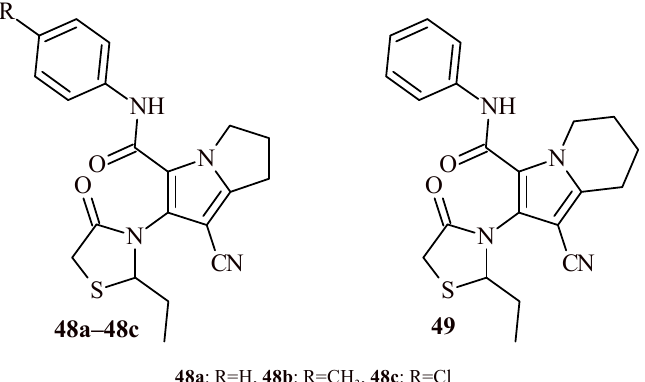
Figure 21. Pyrrolizine-thiazolidin-4-one derivatives with anticancer activity. Lesyk et al. synthesized series of ciminalum-rhodanine hybrids and conducted screening of obtained compounds for their antitumor activity according to the NCI DTP (USA) standard protocol at the concentration in the range 10 − 4 –10 − 8 M against 60 tumor cell lines [55]. The results of screening of ciminalum-rhodanine hybrids confirmed their significant anticancer properties. Compounds 50 and 52 (Figure 22) showed growth inhibition of all tested tumor cell lines at submicromolar and micromolar concentrations. Worth noticing that the most active Compound 52 was active with GI 50 concentration in the range of < 0.01–0.02 µM against following cell lines: MOLT-4, SR (leukemia), SW-620 (colon cancer), SF-539 (CNS cancer), SK-MEL-5 (melanoma). Based on SAR analysis, authors note that the presence of ciminalum moiety turned out to be essential for achievement of the anticancer activity. Furthermore, nature of substituents at Position 3 of thiazolidinone ring is important. Thus, compounds with 4-hydroxyphenyl substituent ( 50 ) and carboxylic acid residue ( 51 , 52 ) were most active against cancer cell lines.